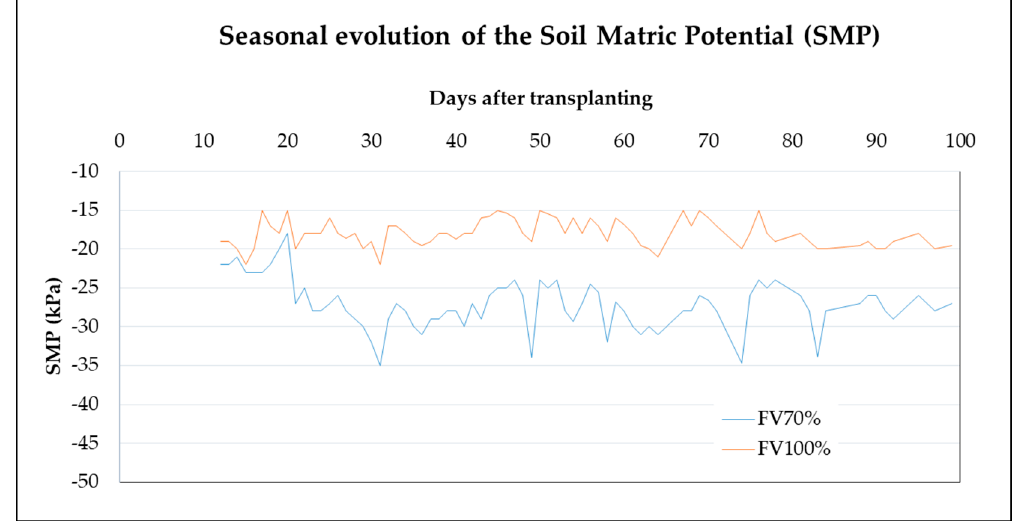
Figure 2. Seasonal evolution of the soil matric potential (SMP) measured at 9.00 a.m., before the irrigation. Mean of 3 values for each level of fertigation volume (FV) (FV70% and FV100%). Measurements taken at 15 cm deep below the gravel–sand layer and 15 cm of the plant.